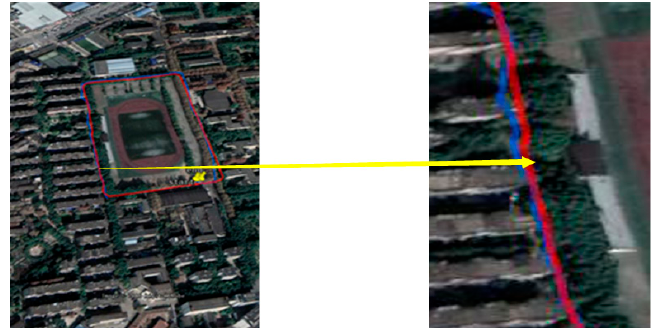
Figure 10. Coordinate of lanes on GIS (Geo-Information System) map.